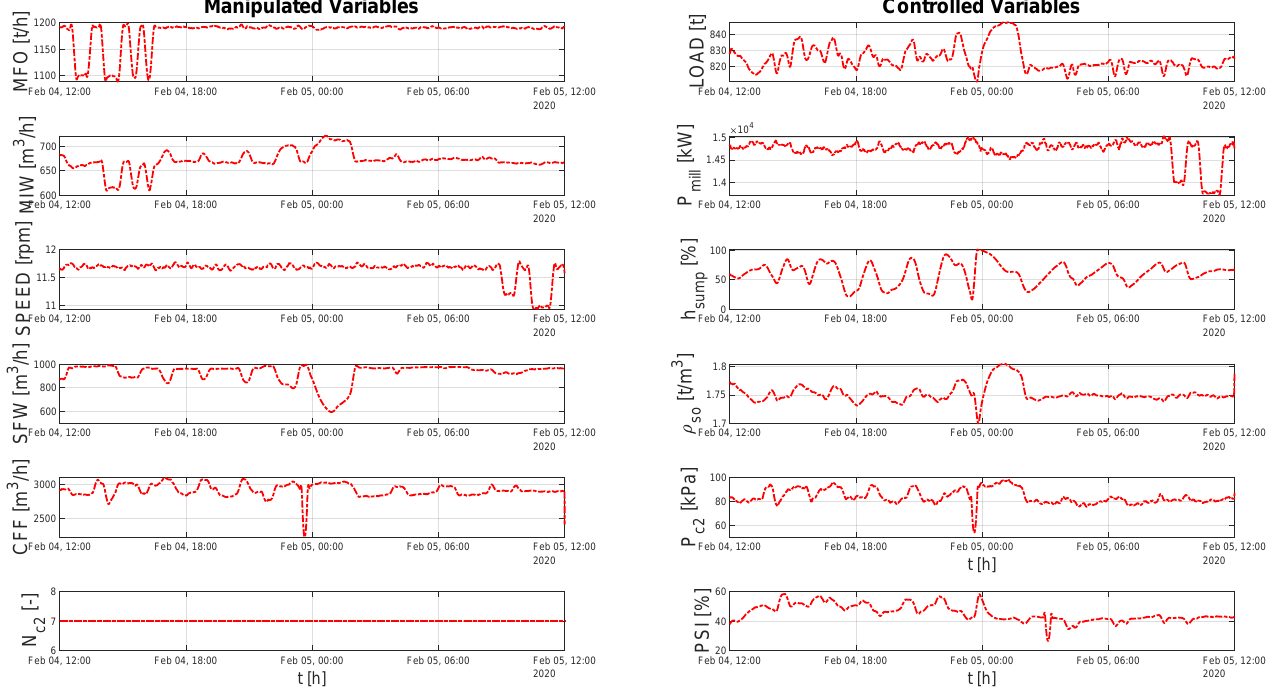
Figure 9. MVs and CVs for the planned step test